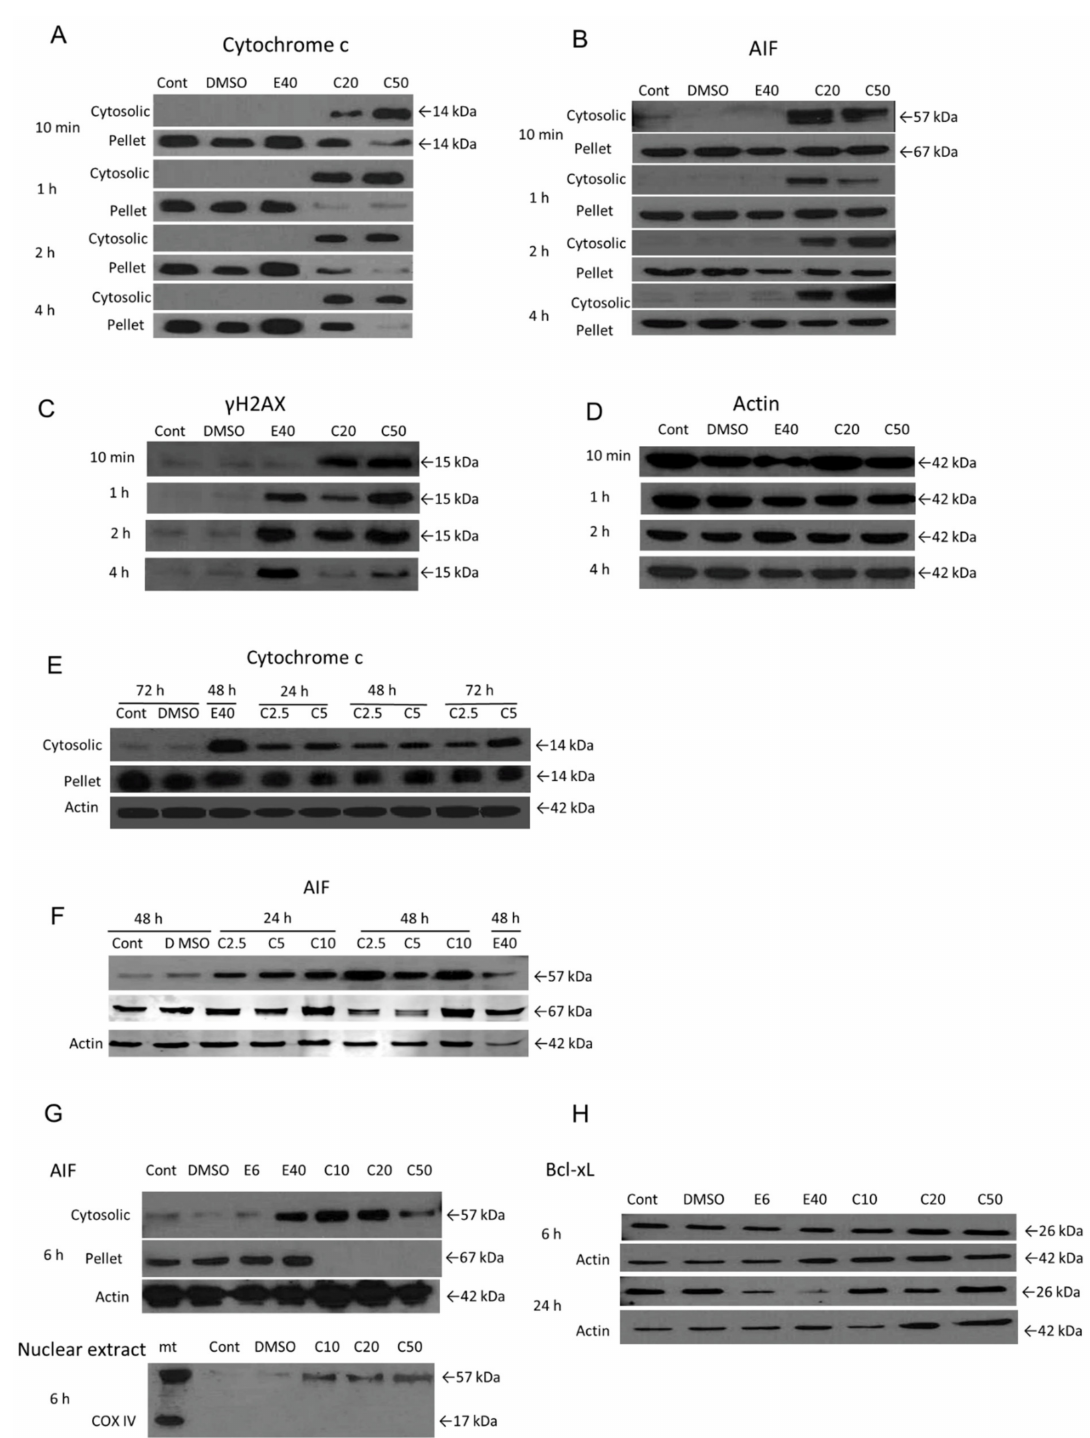
Figure 5. The role of mitochondria and DNA damage in COL-3-induced cell death. Cells were treated with COL-3 (C, 2.5–50 µ g/mL) for 72 h and processed for subcellular fractionation and Western blotting as described in the Materials and Methods section. Controls included etoposide- treated cells (positive control) (E, 6 or 40 µ g/mL), DMSO treated (vehicle control) and untreated cells. Cytosolic translocation of cytochrome c ( A , E ) and AIF ( B , F ); protein expression of γ H2Ax ( C ); AIF nuclear translocation ( G ); protein expression of Bcl-xL ( H ). ( D ) represents the house-keeping protein (Actin, 42 kDa) associated with ( A – C ). COX IV = cytochrome c oxidase complex IV subunit II; mt = mitochondrial-rich